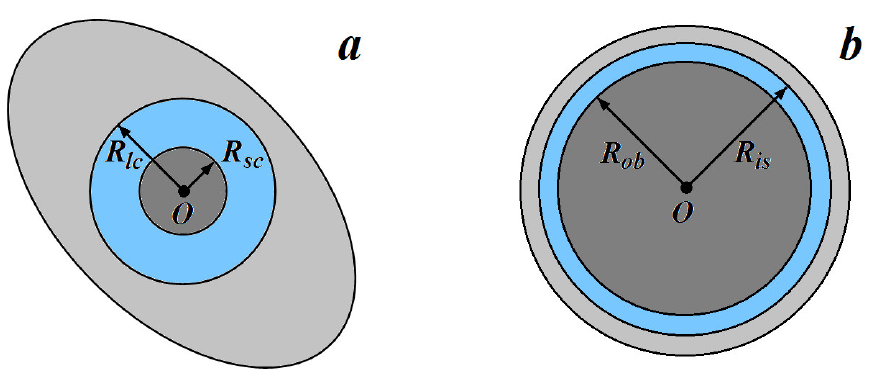
Figure 1. Celestial objects modeled as multi-shell structures: ( a ) “planet” (small inner core), ( b ) “icy satellite” with thin outer layer of ice, covering the subsurface ocean. In the case of a “planet,” the radii of the inner and outer boundaries of the liquid layer are denoted by R sc and R lc ; in the case of an icy satellite, they are denoted by R ob and R is , respectively. The visible contours of a body can have any shape; the only thing that matters is that the center of mass of the outer component coincides with the center of the